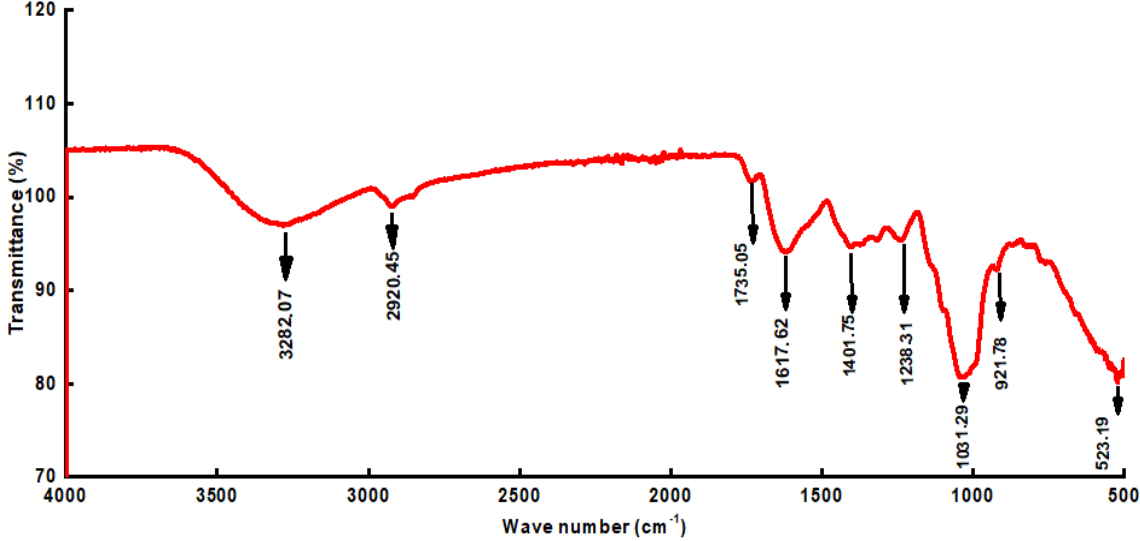
Figure 4. FTIR result for chemical composition.